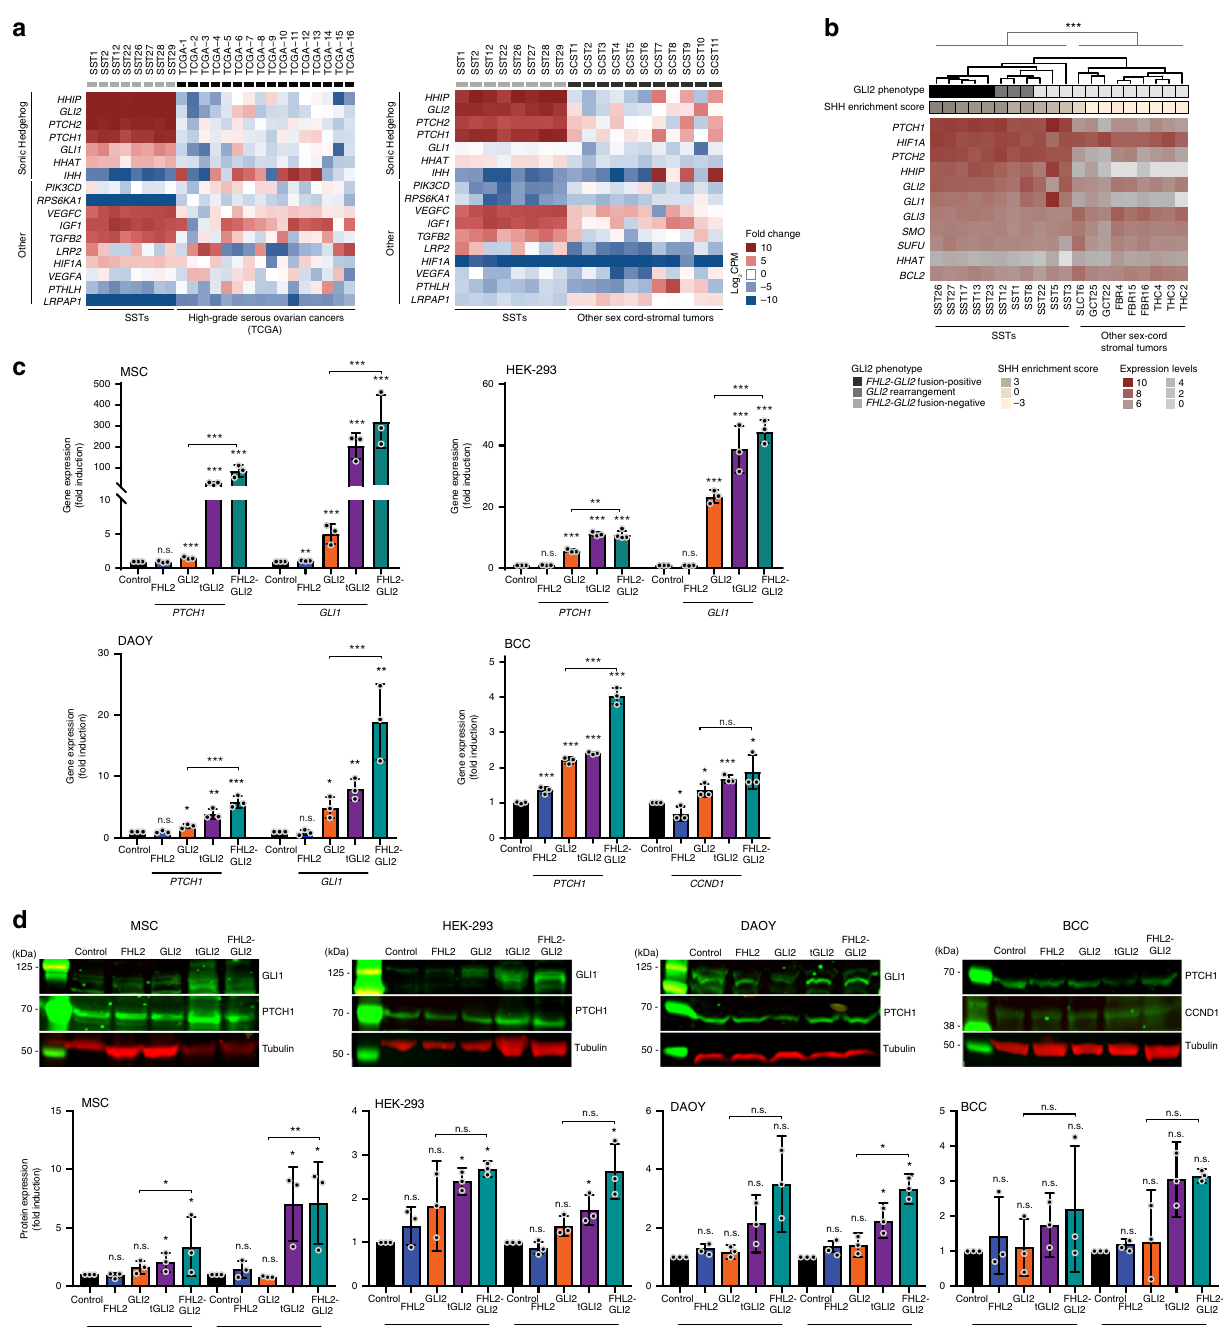
Fig. 4 Expression of the FHL2-GLI2 fusion results in the activation of the Sonic Hedgehog pathway. a Differential gene expression analysis of human sclerosing stromal tumors (SSTs) subjected to RNA-sequencing ( n = 8, this study) and high-grade serous ovarian carcinomas ( n = 16; The Cancer Genome Atlas) and other sex cord-stromal tumors (SCSTs, n = 11; this study). Gene expression fold-change is color-coded according to the legend. Only genes signi fi cantly differentially expressed ( P < 0.05; two-tailed unpaired t -test) are shown. CPM, count per million. b Expression levels of Sonic Hedgehog (SHH) pathway genes in human SSTs ( n = 11) and other sex-cord stromal tumors ( n = 9) as de fi ned using NanoString. Expression levels and SHH enrichment scores are color-coded according to the legends. *** P < 0.001, Wilcoxon rank test. Hierarchical clustering was performed using complete linkage and Euclidian distance. c Quantitative assessment of the Sonic Hedgehog pathway PTCH1 and GLI1 transcripts in immortalized mesenchymal stem cells (MSCs), HEK-293 and medulloblastoma (DAOY) cells and of PTCH1 and CCND1 transcripts in human basal cell carcinoma (BCC) cells stably expressing empty vector (control), wild-type FHL2 (FHL2), wild-type GLI2 (GLI2), truncated GLI2 (tGLI2), or FHL2-GLI2. Expression levels were normalized to GAPDH expression, and comparisons of mRNA expression levels were performed relative to control. d Representative western blot analysis of PTCH1 and GLI1 protein expression in MSC, HEK-293 and DAOY cells and of PTCH1 and CCND1 in BCC cells stably expressing control, FHL2, GLI2, tGLI2, or FHL2-GLI2. Tubulin was used as protein loading control. Quanti fi cation (below) of protein levels as compared to control. In c – d , data are representative of at least three independent experiments. Error bars, s.d. of mean; n.s., not signi fi cant; * P < 0.05, ** P < 0.01, *** P < 0.001; two-tailed unpaired t